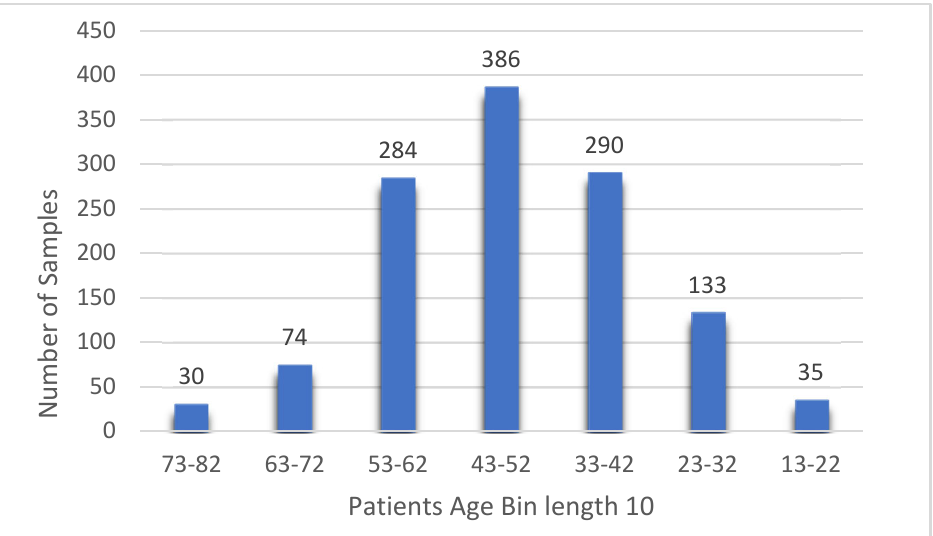
Figure 2. Patient age distribution according to the number of the samples.